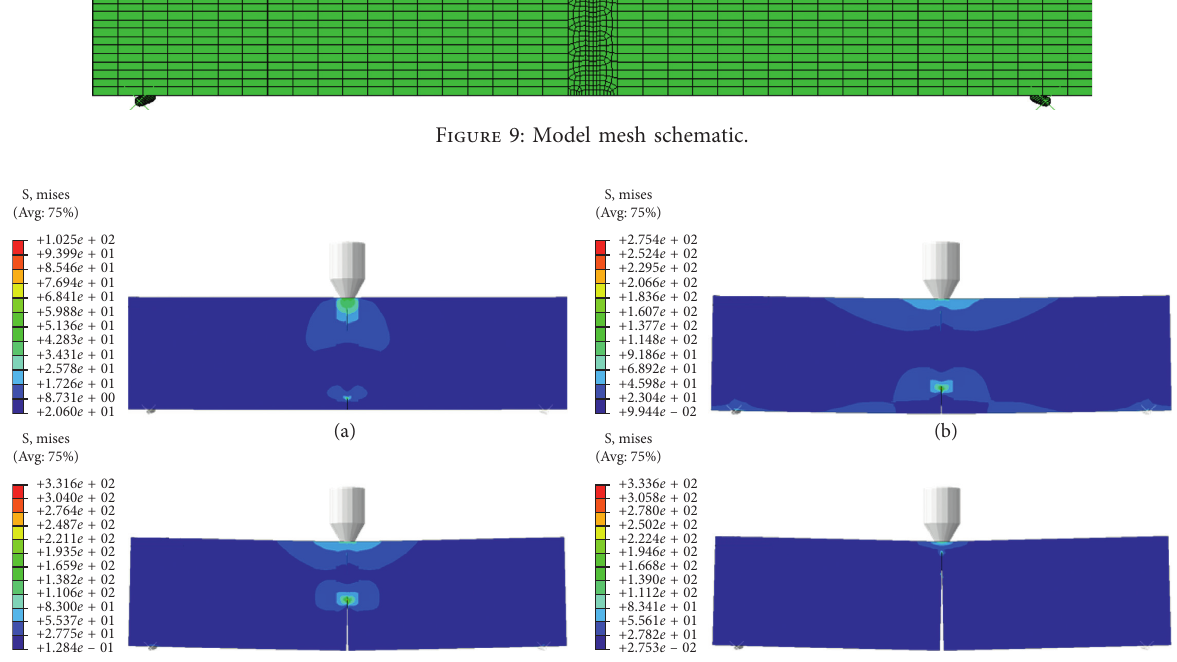
Figure 10: L1 specimen von Mise stress cloud diagram. (a) 76 μ s. (b) 158 μ s. (c) 302 μ s. (d) 360 μ s.